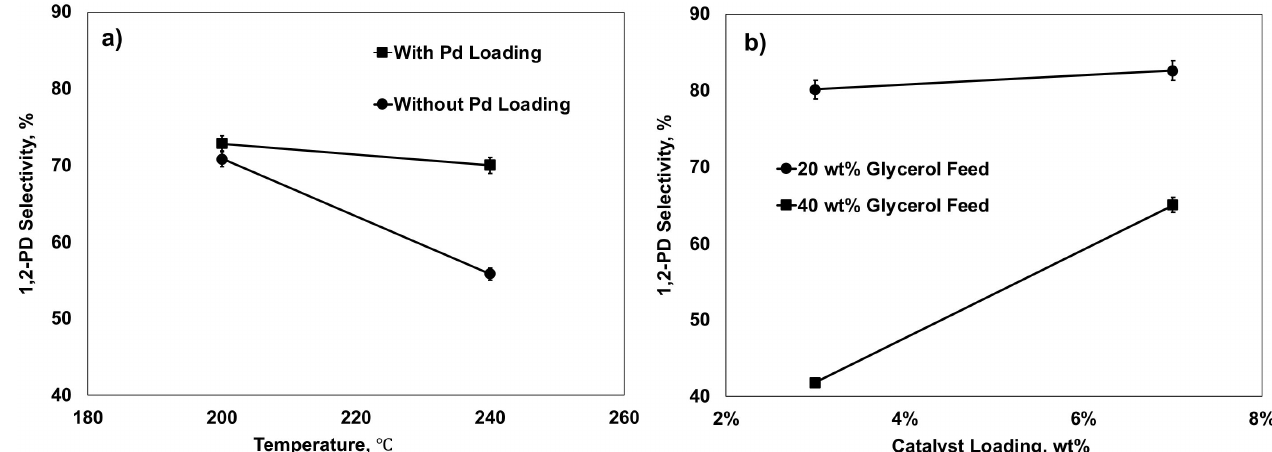
Figure 8. Two-factor interactions on the 1,2-PD selectivity. ( a ) Temperature and Pd loading (AD); ( b ) glycerol feed concentration and catalyst loading (BC), error margin: 95% confidence interval.